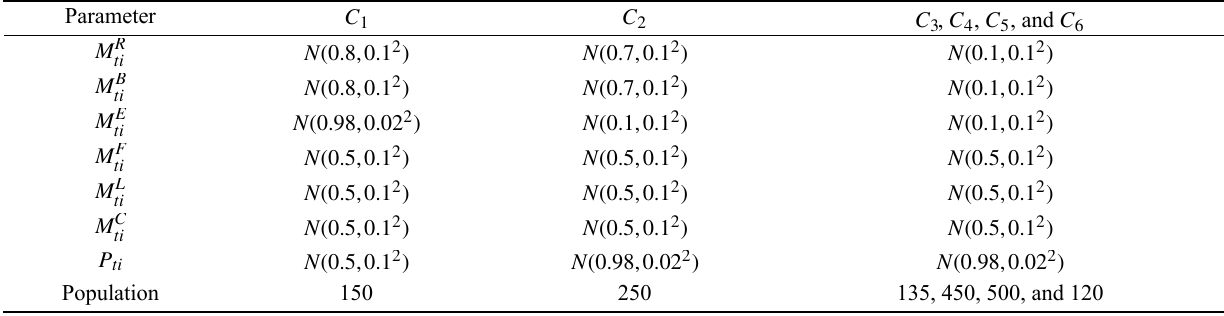
Table 2 Parameter settings for the community characteristic of the second case study, i.e., the society of six separate communities, where means community ( ∈ 1, 2, 3, 4, 5, 6).